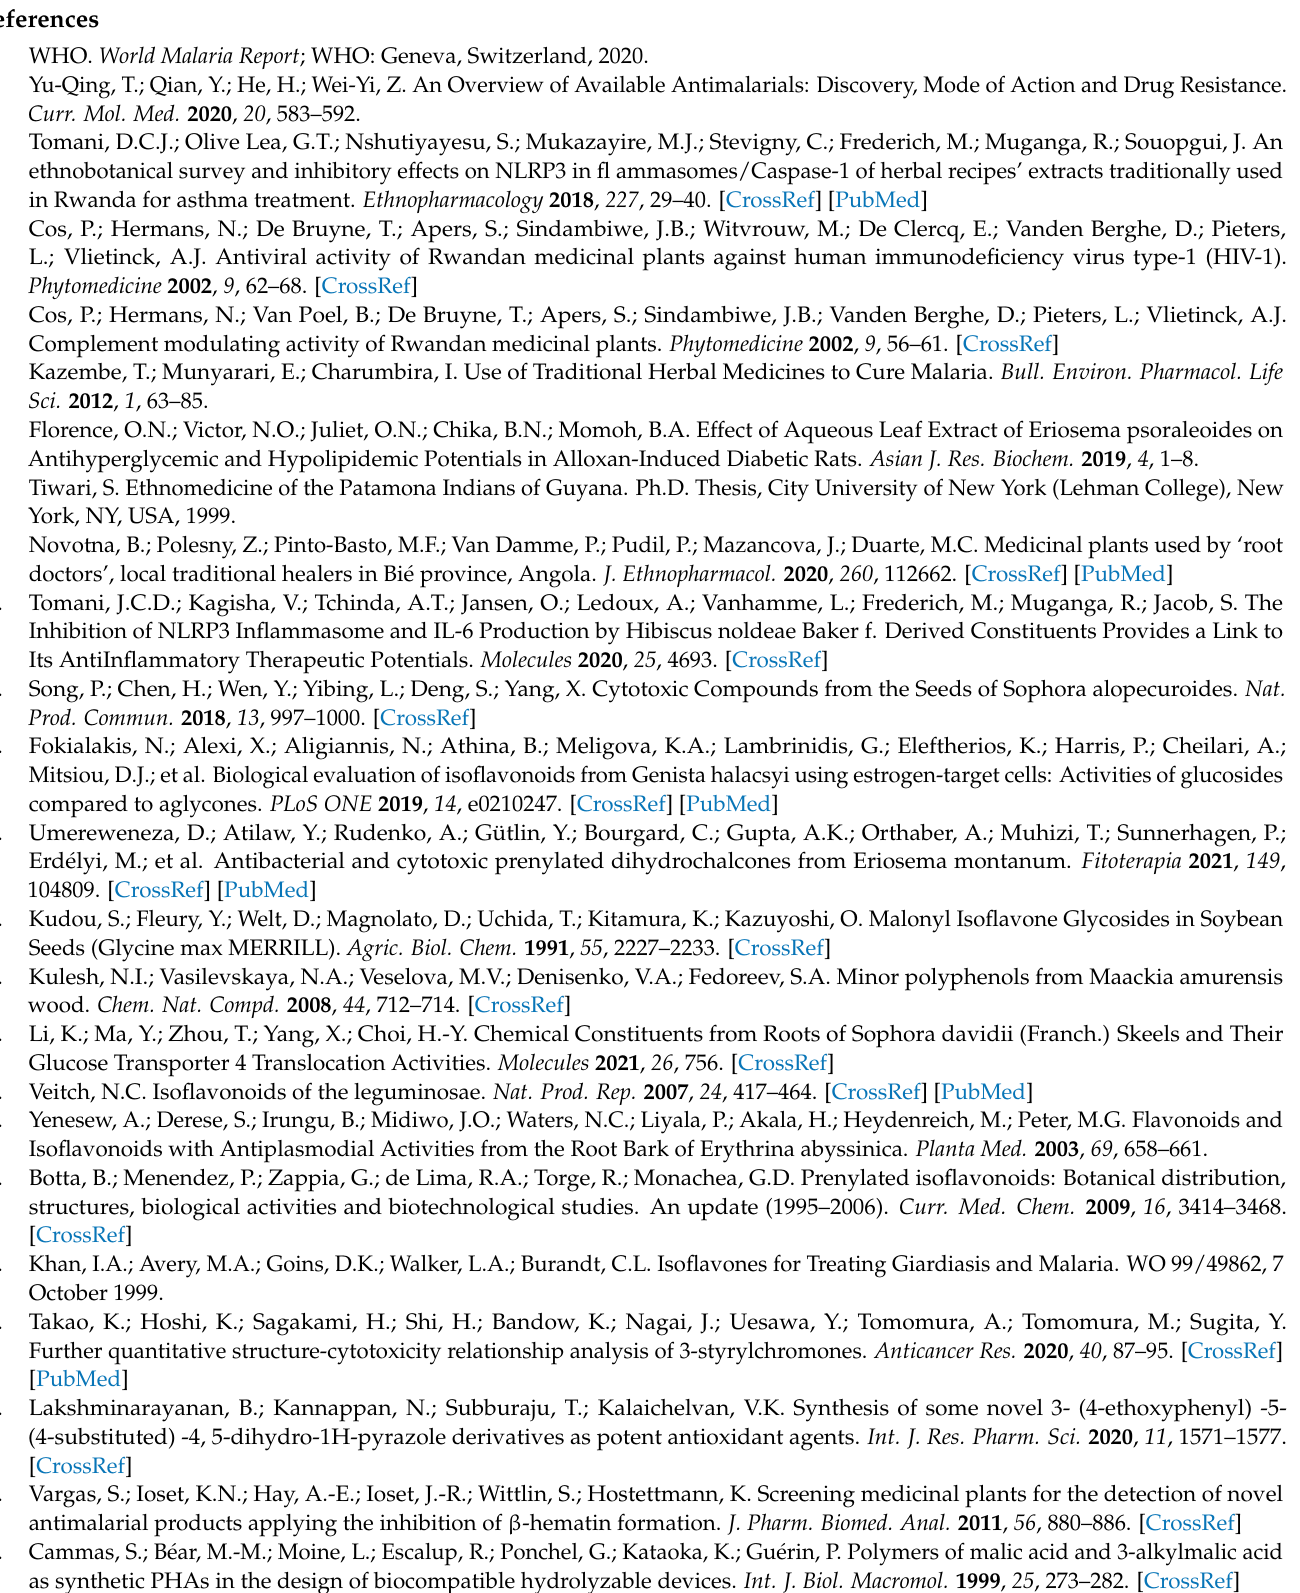
Sample Availability: Samples of the crude extract (2.1 g), fraction 3 (21 µ L) and